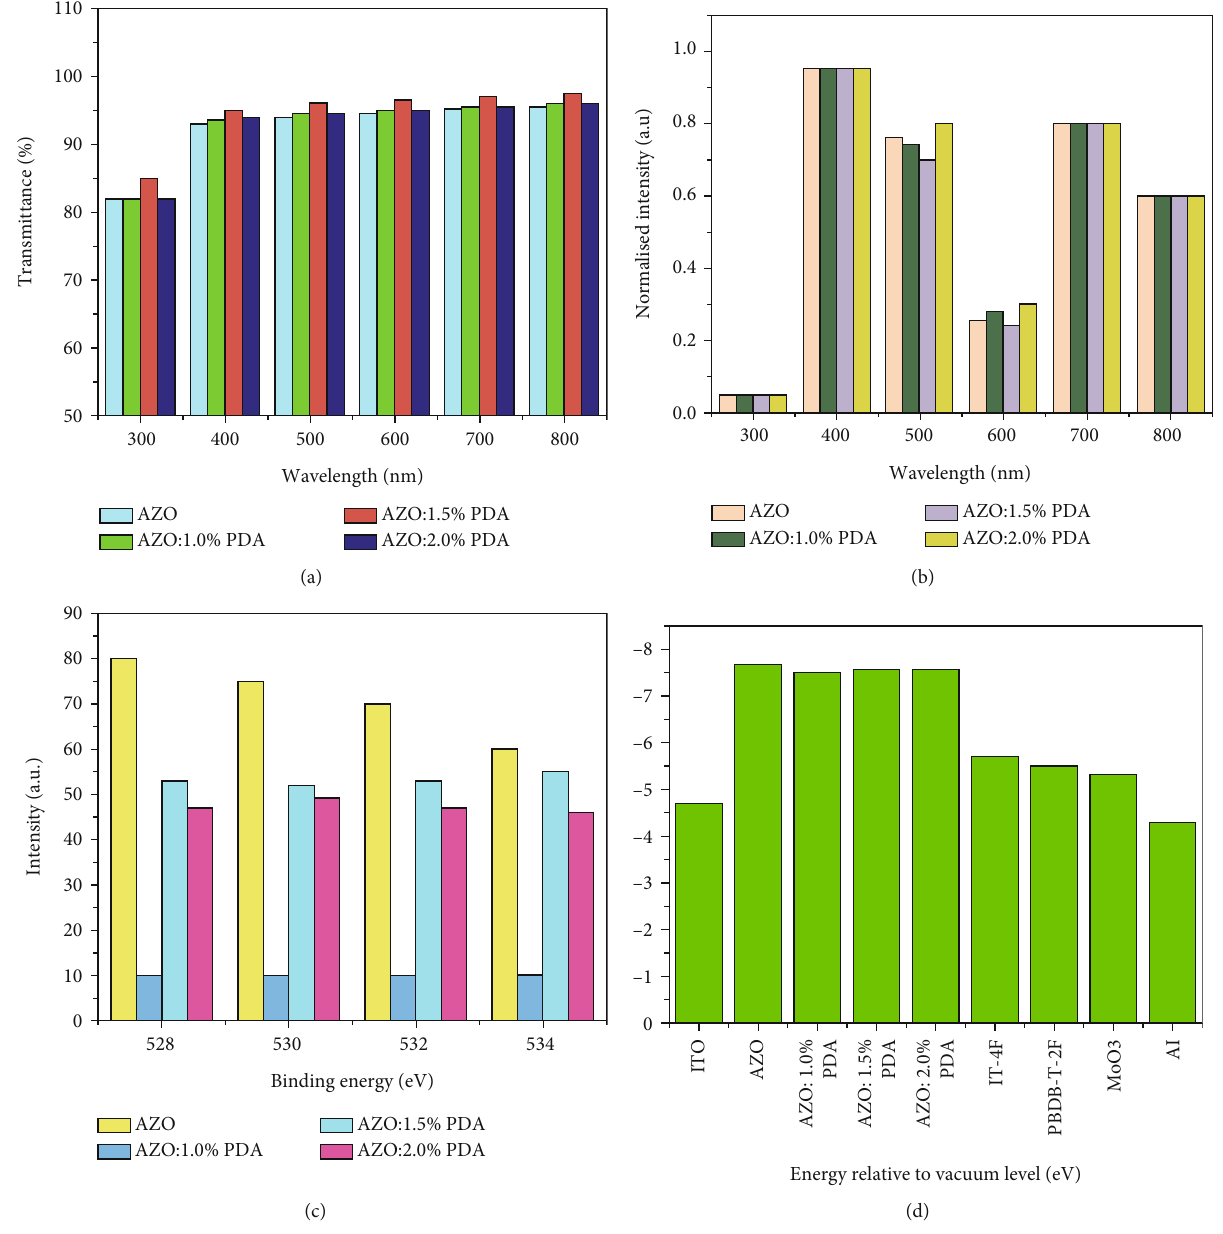
Figure 2: AZO performance in terms of (a) transmission spectra, (b) room temperature excitation of 315nm excitation PL, (c) X-ray photoelectron spectroscopy, and (d) energy levels in existence of additive